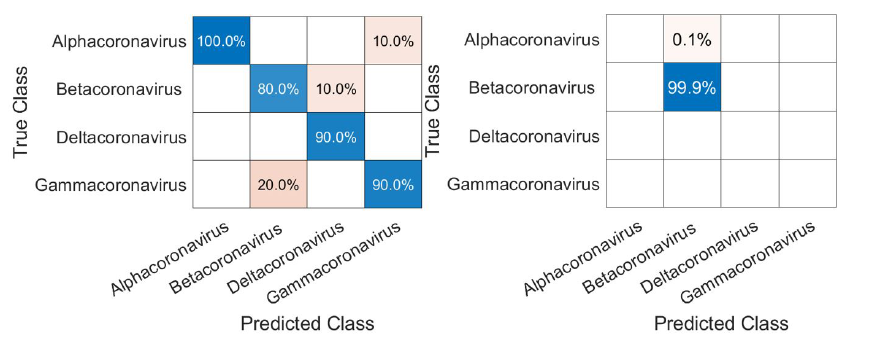
Figure 9. Confusion matrices for validation of the CNN using the genus inside ( Coronaviridae ) the family ( left ) and, for classification of SARS-CoV-2, in its correct genus ( Betacoronavirus ).